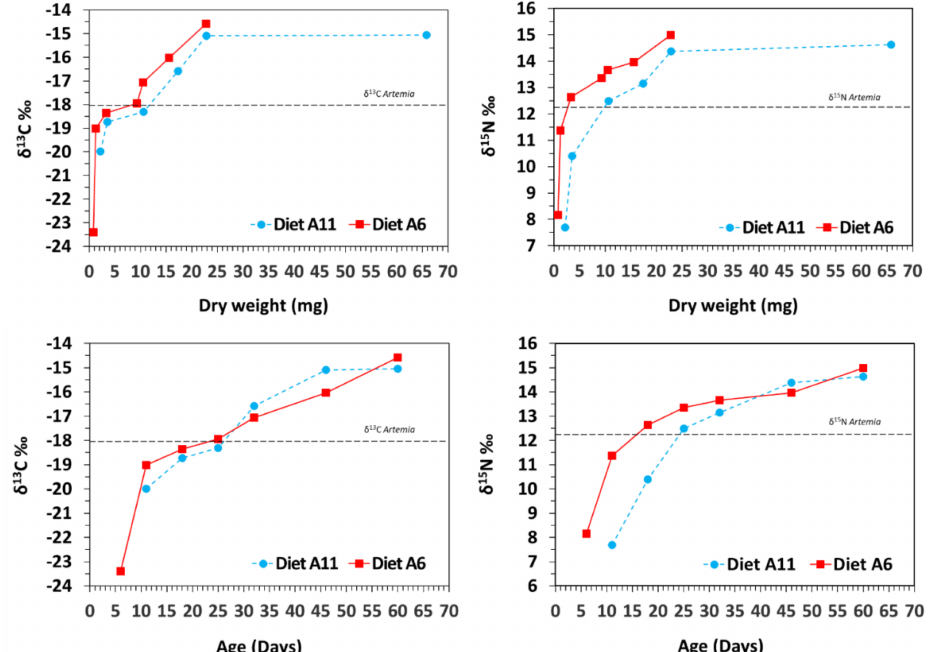
Figure 2. Isotopic ( δ 13 C and δ 15 N) changes in seahorse Hippocampus reidi juveniles fed A6 and A11 diets. Data are provided as means for dry weight (mg; upper) and age (days; bellow). For clarity, sd values are not provided. Diet: nauplii of Artemia (dashed lines; − 18.0‰ δ 13 C; 12.3‰ δ 15 N).